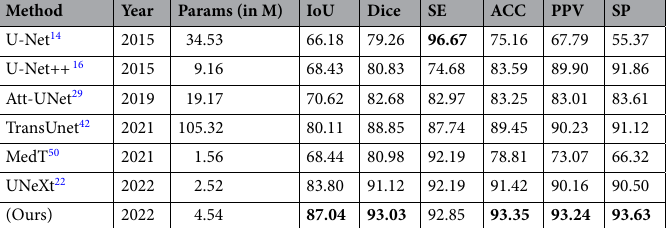
Table 3. Comparison results of the proposed method on GlaS dataset. Significant values are in [bold].